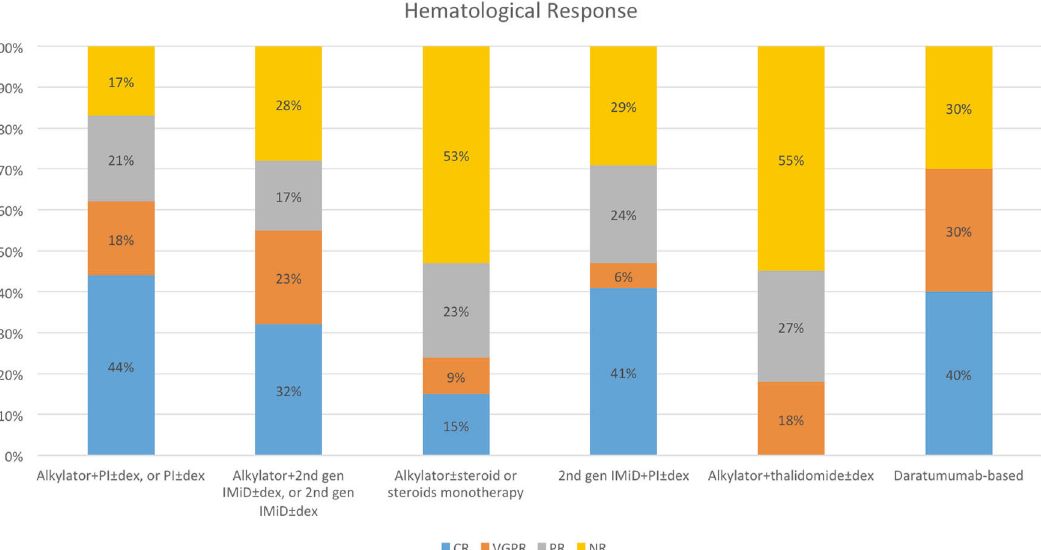
Fig. 1 Hematological response in evaluable patients by the regimen received. PI proteasome inhibitor, dex dexamethasone, gen generation, IMiD immunomodulatory drug, CR complete response, VGPR very good partial response, PR partial response, NR no